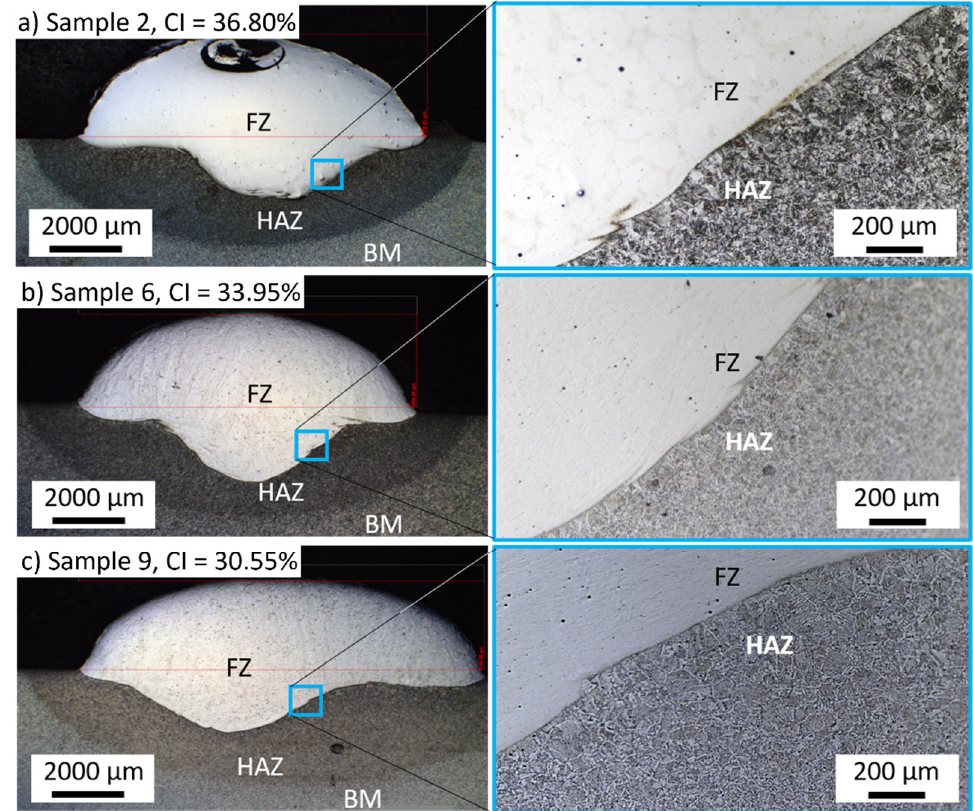
Figure 7. Cross-section of the weld beads for ( a ) sample 2, ( b ) sample 6, and ( c ) sample 9. The fusion zone, heat-affected zone, and base metal are indicated by FZ, HAZ, and BM, respectively.